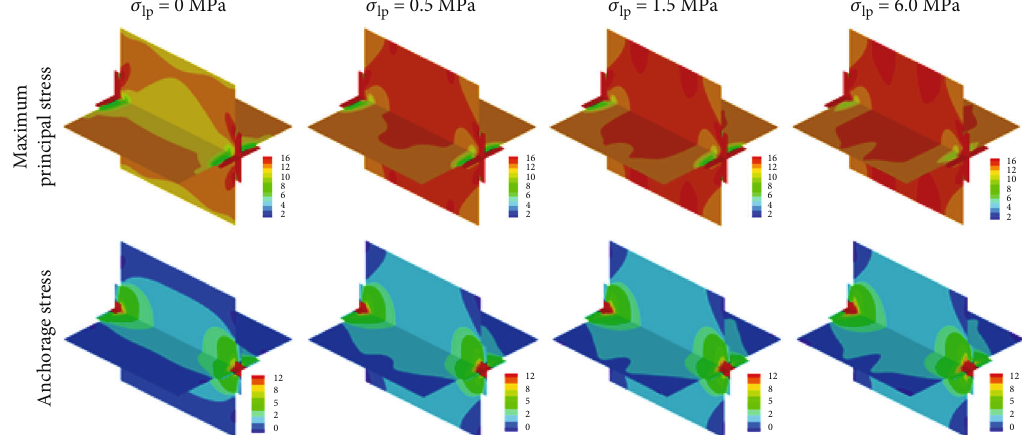
Figure 10: Maximum principal stress and anchorage stress distributions of rock mass specimen with di ff erent lateral